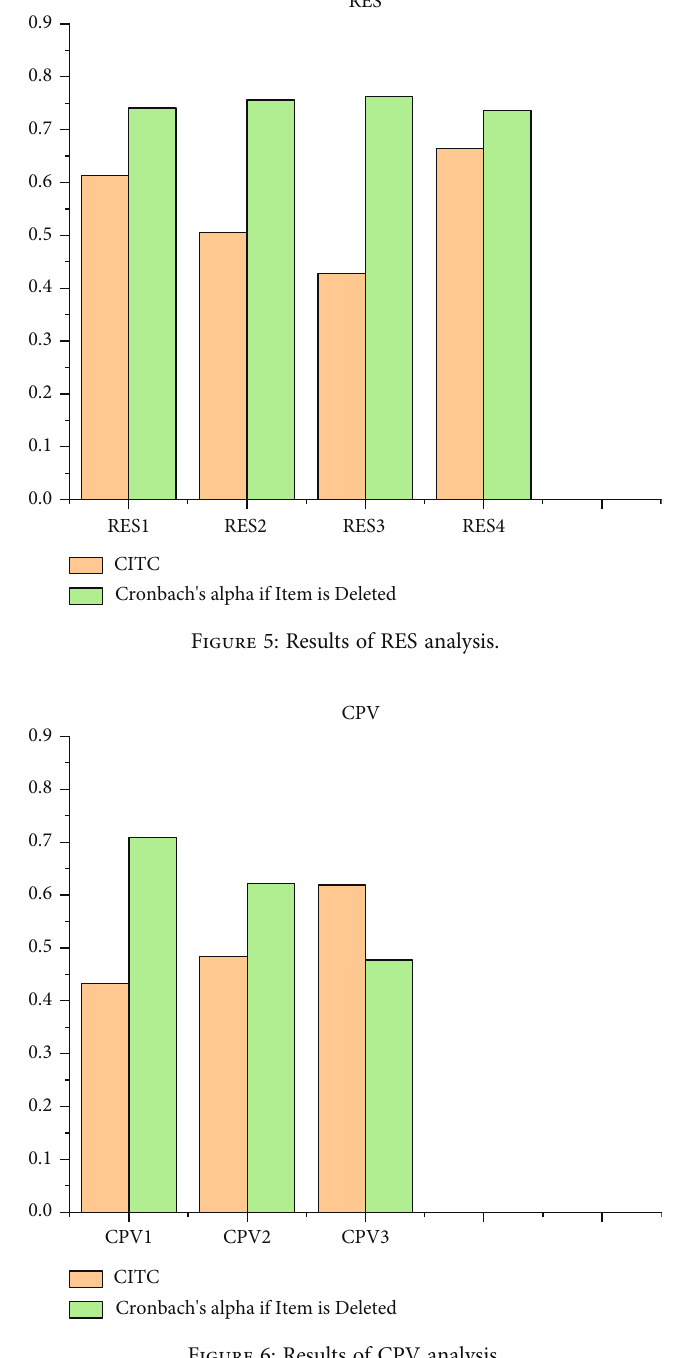
Figure 6: Results of CPV